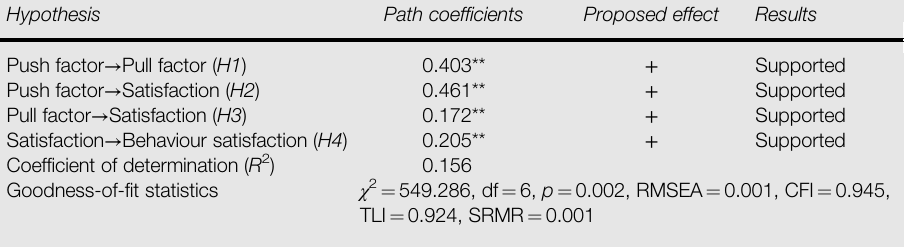
Table VII Structural model results